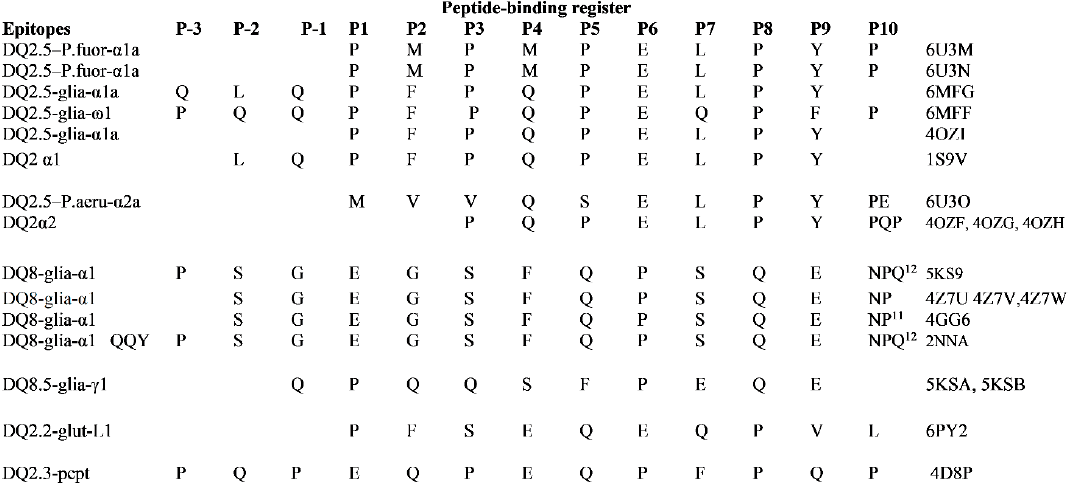
Figure 5. Peptide binding register of immunodominant peptides in complexes with HLA-DQ and T-cell receptor.